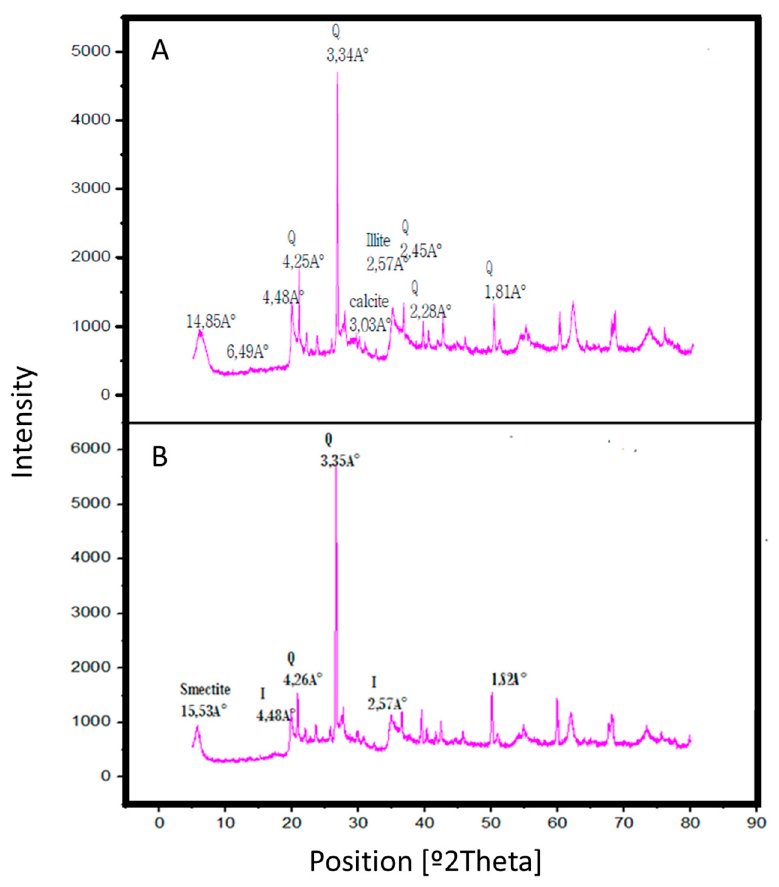
Figure 6. X-Ray di ff raction (XRD) patterns of ( A ) raw clay RC and ( B ) acid activated clay AC with HCl Figure 6. X-Ray diffraction ( XRD) patterns of ( A ) raw clay RC and ( B ) clay AC activated acid 3 N for 1 activated clay AC with HCl 3 N for 1 h.